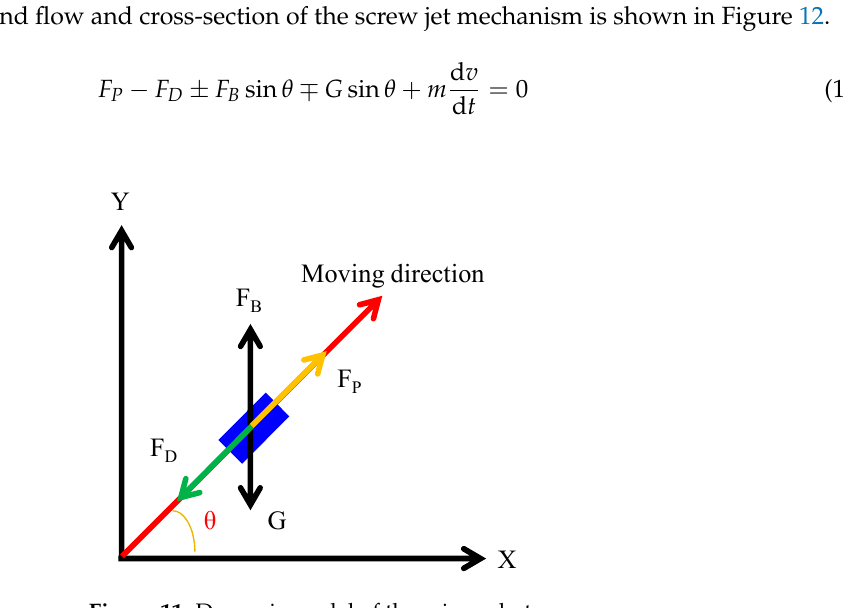
Figure 11. Dynamic model of the microrobot.